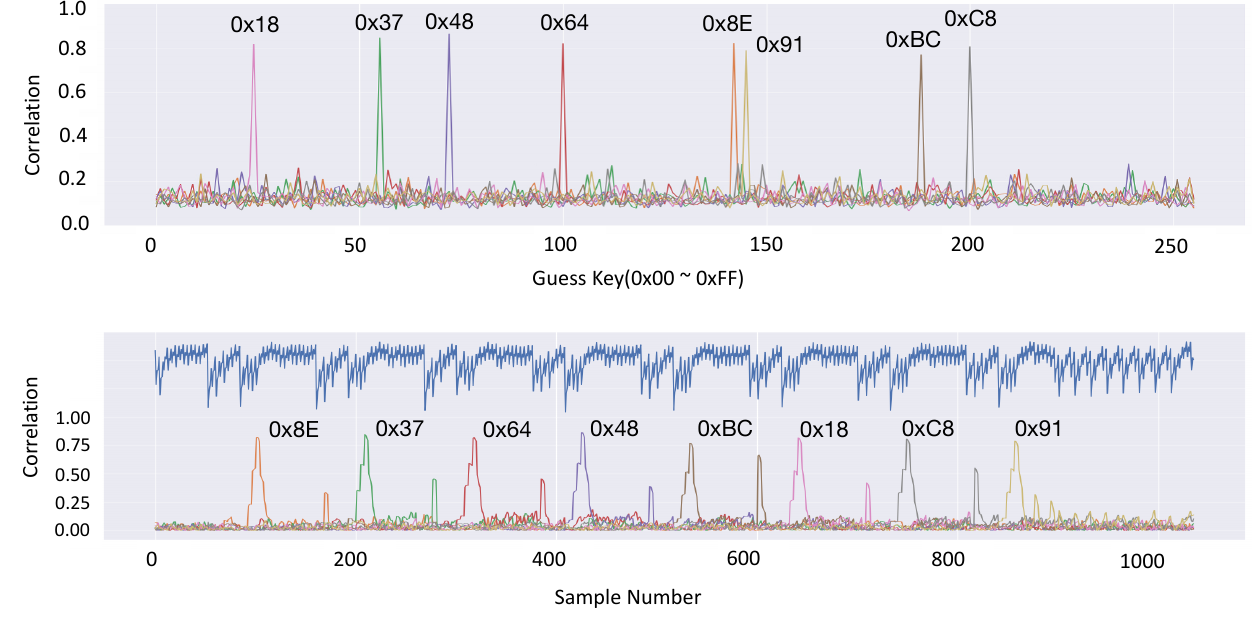
Figure 8. Top : correlation attack results, bottom : correlation test